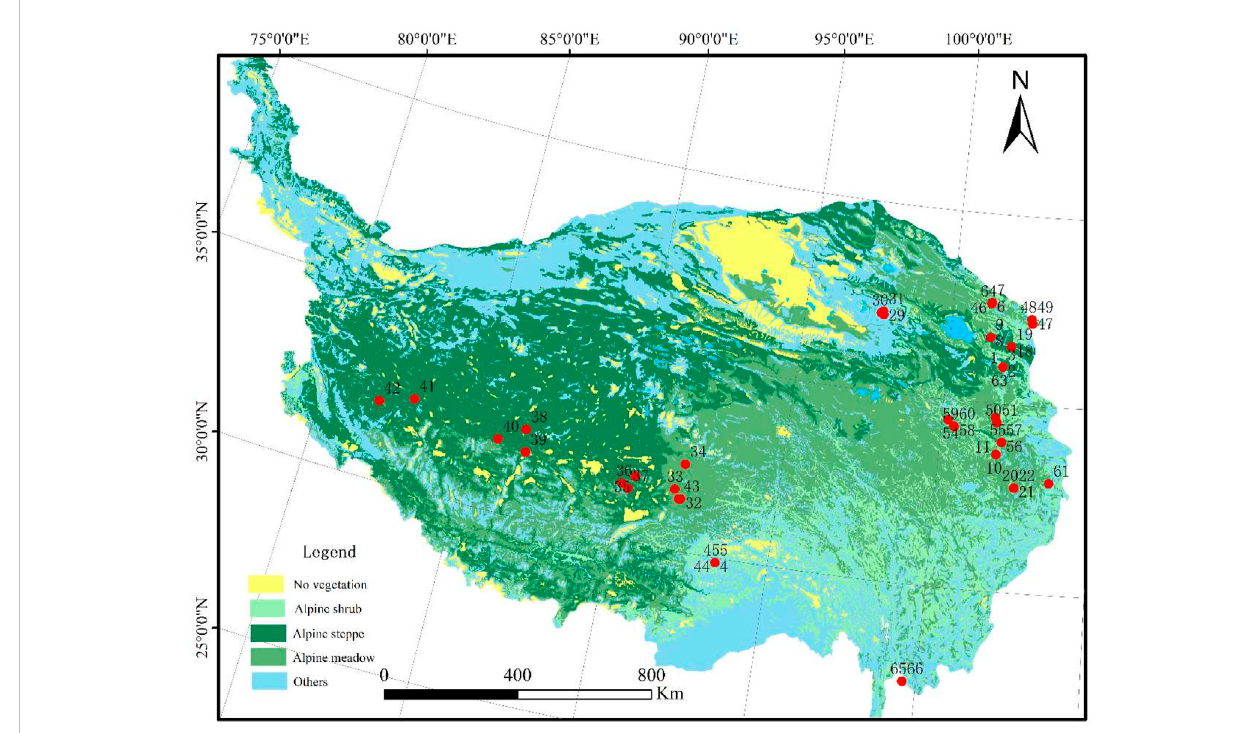
FIGURE 1 Main vegetation types distribution and 66 research sites on the Tibetan Plateau.